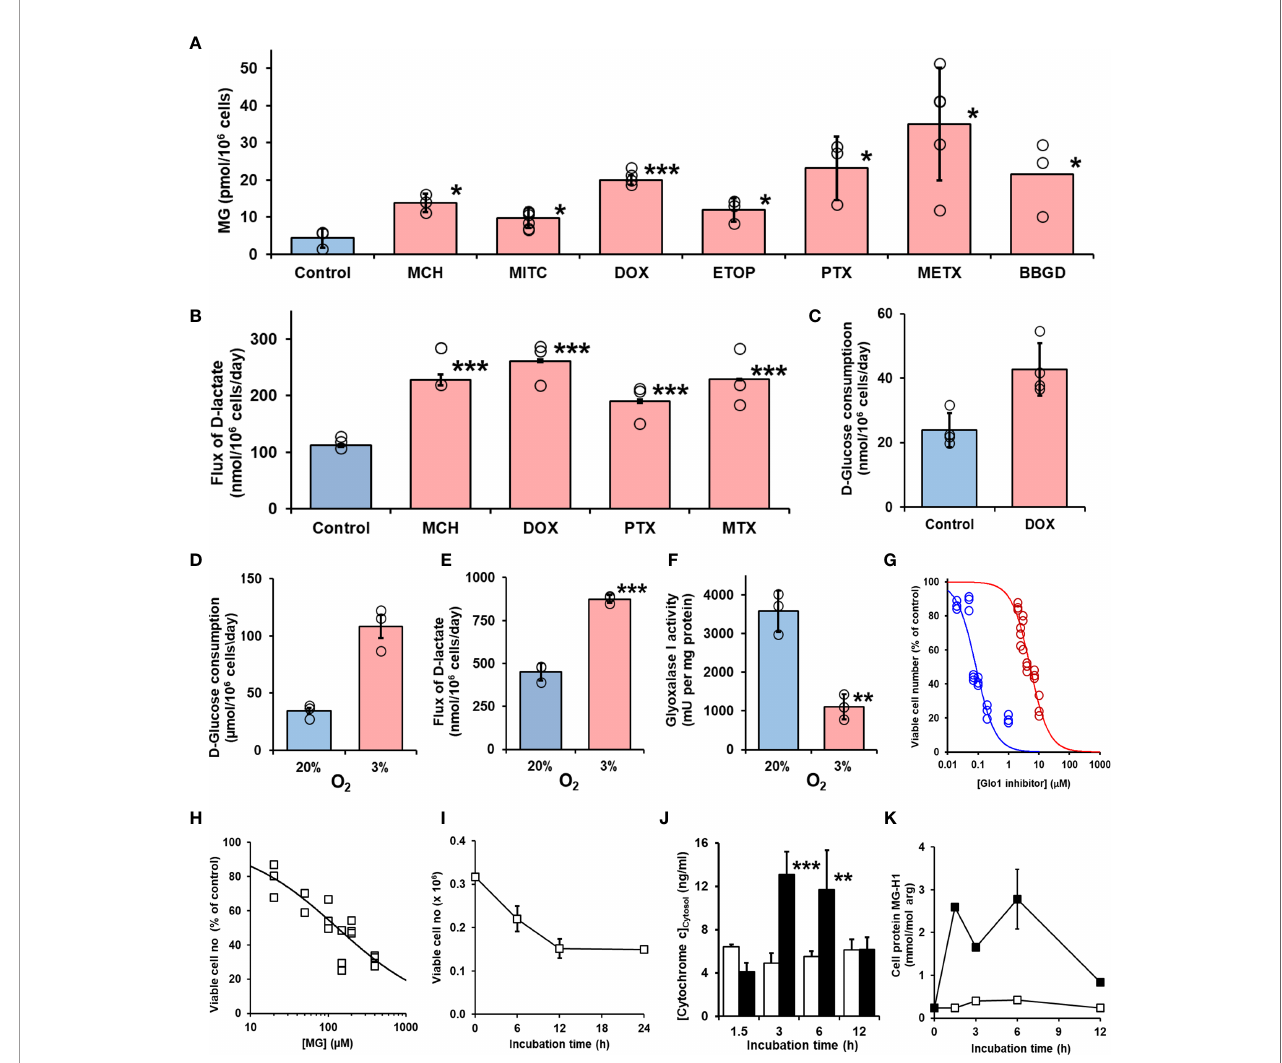
FIGURE 3 | Induction of cellular dicarbonyl stress by antitumor drugs and mechanism methylglyoxal-induced cytotoxicity. (A) Increase in cellular MG in HEK293 cells treated with antitumor drugs for 3 h. Control (no drug added) and ca. 2 × GC 50 concentration in nontransfected cells: mechlorethamine (MCH, 4.8 µM), mitomycin C (MITC, 316 nM), doxorubicin (DOX, 6.0 nM), etoposide (ETOP, 323 nM), paclitaxel (PTX, 21 nM), methotrexate (METX, 7.6 nM), and BBGD (7.4 µM). Data are mean ± SEM ( p < 0.001; one-way ANOVA ; n = 3 except n = 4, 5, and 6 for DOX, METX, and MITC, respectively). (B) Flux of formation of D-lactate (surrogate for fl ux of MG) and (C) fl ux of glucose consumption incubated in vitro with and without investigational agent and drugs indicated. Cells were incubated for 24 h with and without 2 × GC 50 concentration. Data are mean ± SEM ( n = 3). (D – G) Effect of hypoxia on formation and metabolism of methylglyoxal and antiproliferative activity of BBGD. (D – F) ) Flux of glucose consumption and formation of D-lactate and Glo1 activity of HEK293 cells incubated for 72 h in 20% and 3% oxygen, models of normoxia and hypoxia, respectively. Data are mean ± SEM ( n = 3). (G) Dose-response curve for BBGD. The GC 50 values for BBGD under normoxic and hypoxic conditions were 5.12 ± 0.33 µM and 0.085 ± 0.010 m M, respectively ( N = 18). (H) Dose-response curve for MG-treated HEK293 cells. GC 50 131 µM ± 19.1,